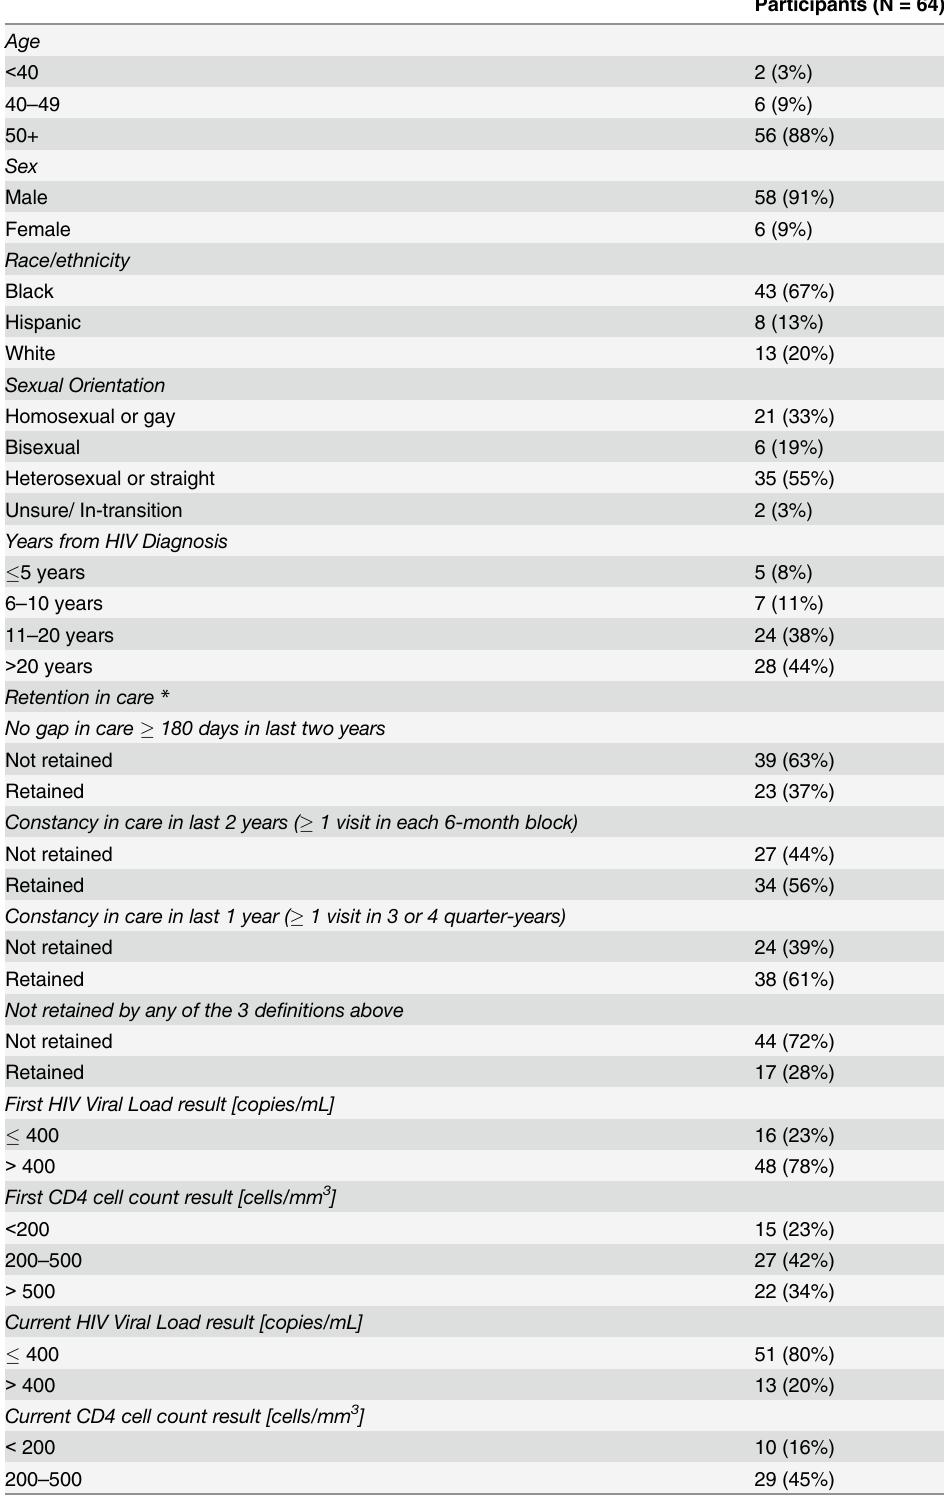
Table 1. Demographic and clinical characteristics of participating patients (N =